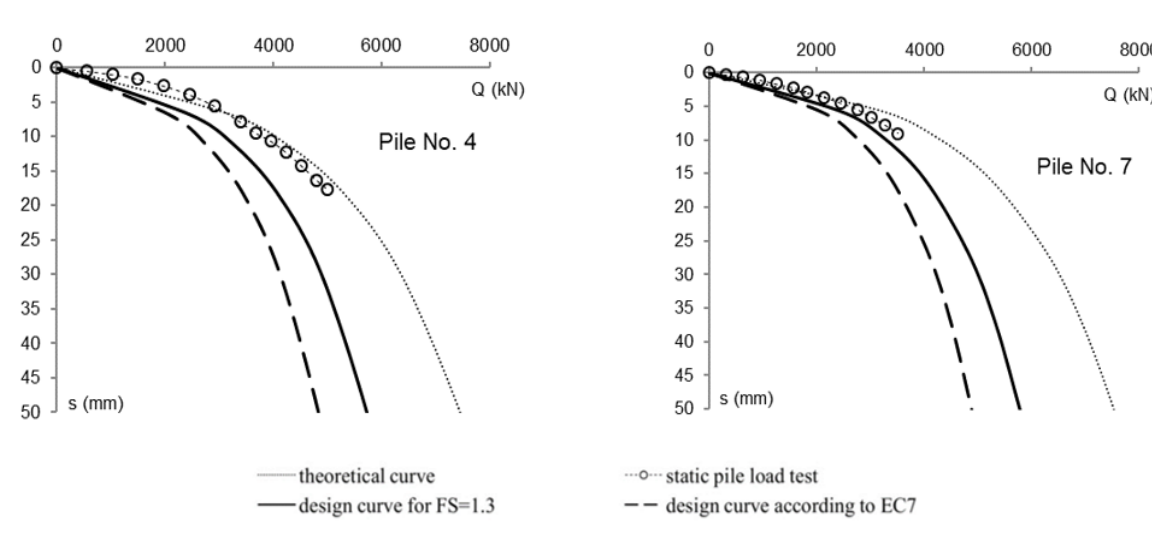
Figure 12: Comparison of design curves and curves from SPLT.